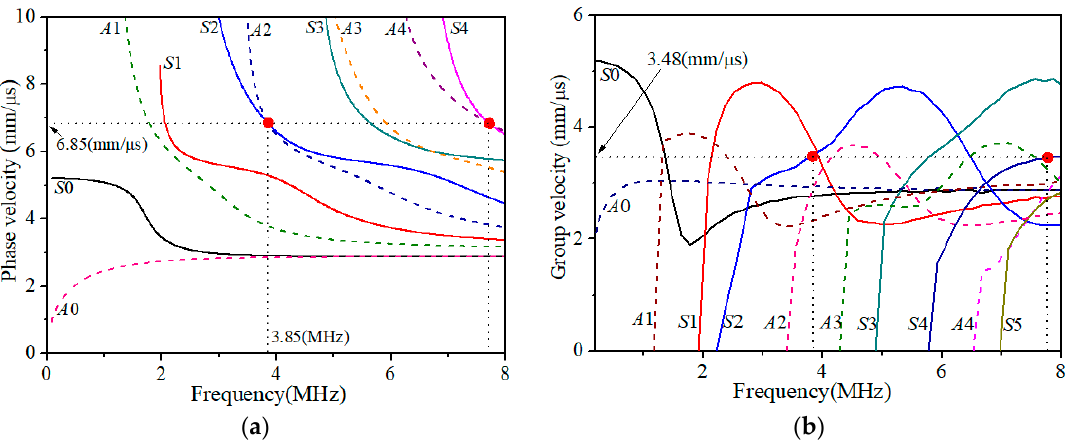
Figure 3. ( a ) Phase velocity and ( b ) group velocity dispersion curves for Lamb waves in the 201 stainless steel with a thickness of 1.35 mm.